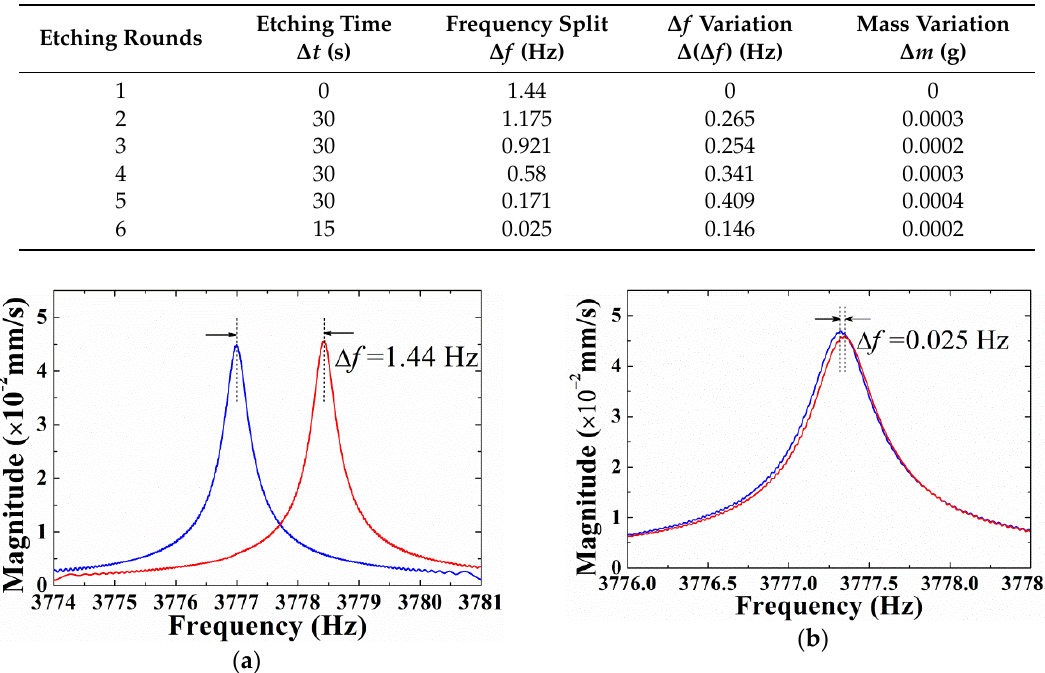
Figure 10. Frequency splits of H02 before and after chemical etching: ( a ) Before chemical etching, ∆ f = 1.44 Hz; ( b ) After chemical etching, ∆ f = 0.025 Hz.